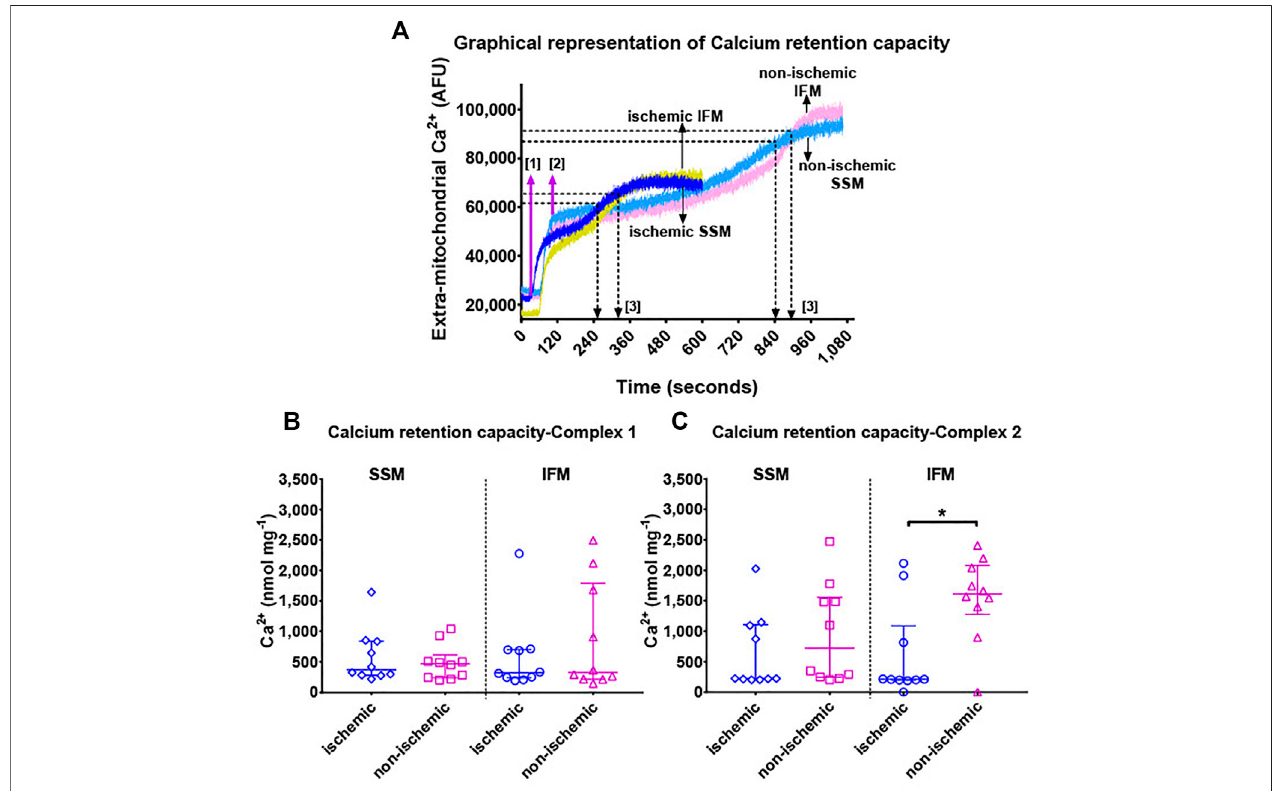
FIGURE 4 | Panel (A) : Representative Ca 2+ retention capacity assay tracings in terms of Ca 2+ Green fl uorescence over time. Continuous infusion of 5 mM Ca 2+ enters the cuvette over time at the rate of 30 μ L min − 1 . Extra-mitochondrial Ca 2+ (in arbitrary fl uorescence units [AFU], indicated on the y -axis) is measured by Ca 2+ Green.Atthestartoftheexperiment,assaybuffercontainingCa 2+ Green,mitochondriaandsubstratesareaddedtothecuvette withoutanyexternaladditionofCa 2+ .A baseline measurement is taken for about 100 s, after which, a continuous infusion of Ca 2+ was started using a syringe pump at the rate of 30 μ L min − 1 . This is indicated by step [1] in magenta arrows. The addition of Ca 2+ leads to an immediate spike up until [2], which forms the new baseline for Ca 2+ levels within the mitochondria.AsCa 2+ isconstantlytakenupintothemitochondriaatarateapproximatelyequaltotheinfusion,extra-mitochondrialCa 2+ remainsrelativelystable.When the maximum calcium retention capacity is reached, mitochondria removes excess Ca 2+ out of its membrane, and hence the extra-mitochondrial Ca 2+ signal starts increasing. This increase reaches a plateau when the mPTP opens and all of the mitochondrial Ca 2+ is released into the cuvette. Black arrows and [3] indicate the time corresponding to the maximum Ca 2+ concentration that the mitochondria in these particular experiments could tolerate, before the opening of mPTP. This maximum concentration of Ca 2+ administered over the total duration of infusion yields the total calcium retention capacity. Panels (B,C) show mitochondrial calcium retention capacity using complex I (pyruvate + malate) and complex II (succinate + rotenone) substrates, respectively. Values are represented as median with interquartile range ( n = 9 – 10/group). * indicates p ≤ 0.05 (two-tailed) compared to ischemic tissue. For exact p -values of all group comparisons, please refer to Table 2 .